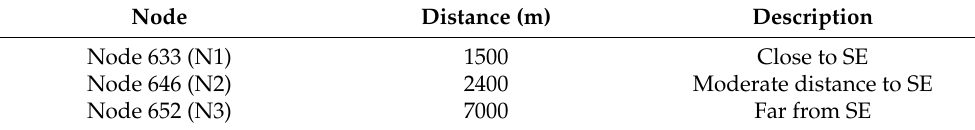
Table 1. Location (node) and distance of the DG from the substation (SE).